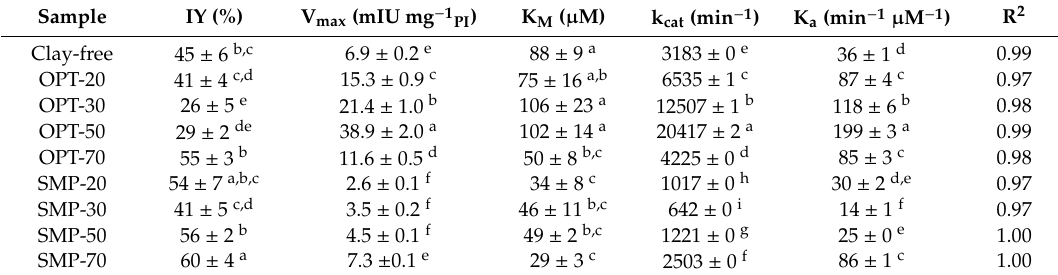
Immobilization yield and kinetic properties of papain immobilized on the CS–clay nanocomposite